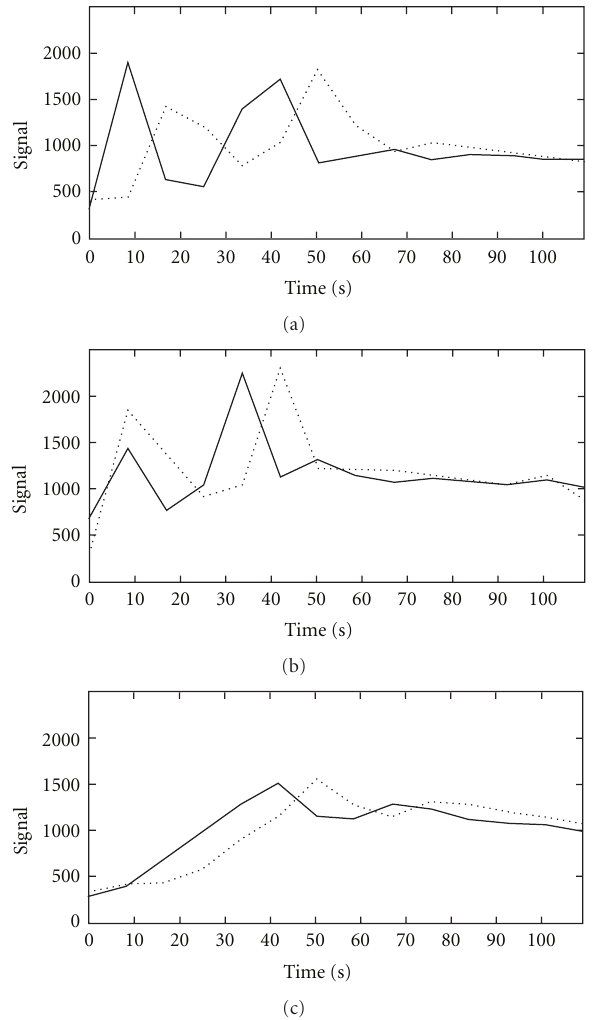
Figure 3: Mean signal curves over time for ROIs positioned in the carotic bifurcation (solid lines) and ROIs placed in the jugular vein (dashed lines) for the patients shown in Figure 2 top row (a) and bottom row (b) and a patient with cardiovascular disease and extreme bolus dispersion (c).